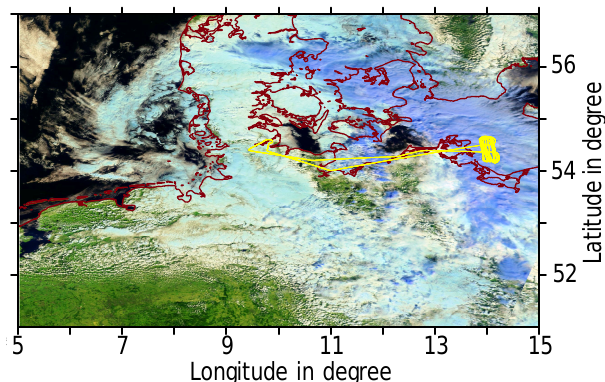
Figure 5. MODIS high-resolution picture of the northern part of Germany, taken at 11:00UTC on 4 September 2013. Low stratus clouds are marked in white and the observed cirrus is marked in blue. The yellow line indicates the flight path of the